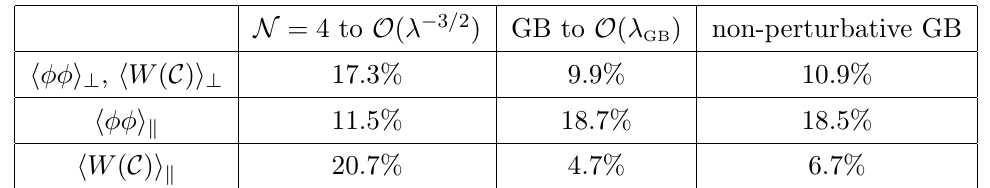
Table 1 . Increase of the critical time in N = 4 SYM theory at (cid:13) (cid:25) 8 : 33 (cid:2) 10 (cid:0) 4 ( (cid:21) (cid:25) 31 : 9) and in a dual of Gauss-Bonnet theory at (cid:21) = (cid:0) 0 : 025. Both choices of the coupling correspond to a GB 10% increase of (cid:17)=s . We use ? and k subscripts to denote transverse and longitudinal operators, respectively.